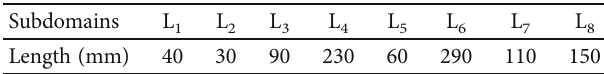
Figure 12: Con fi gurations of the TRB concept tube without transition zone. Table 3: Length of the TRB concept tube without transition